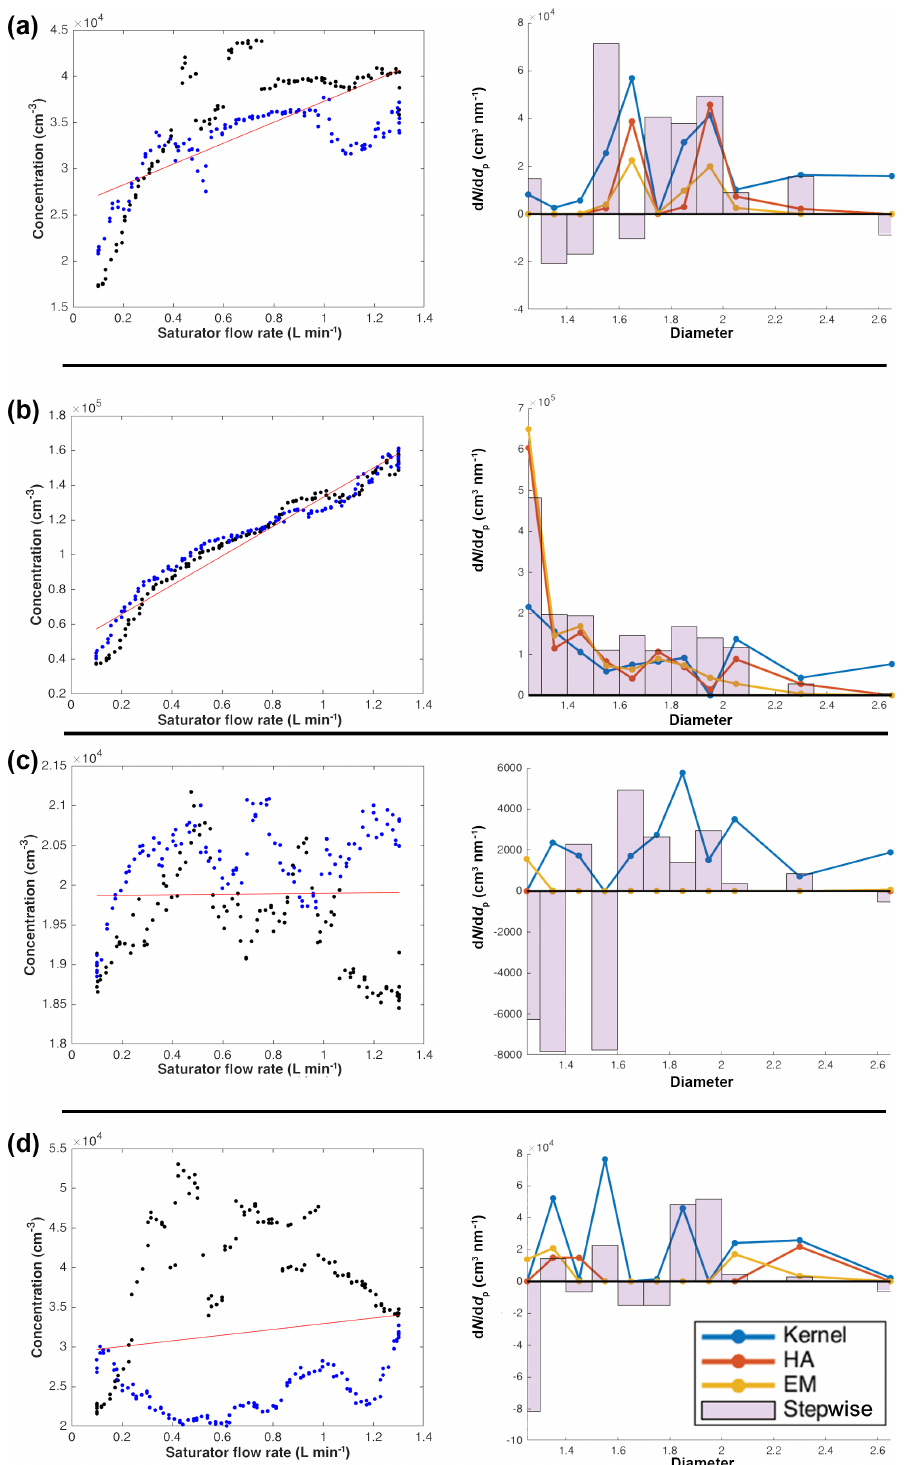
Figure 1. The 4min retained (a, b) and discarded (c, d) scans using the PSM (left column) and their inversion into a particle size distribution (right column). The black dots indicate the (2min) upward scan of the saturator flow, and the blue dots indicate the corresponding (2min) downward scan of the saturator flow. The red line indicates the regression line of the 4min scan. An 11-channel size bin range was used for the